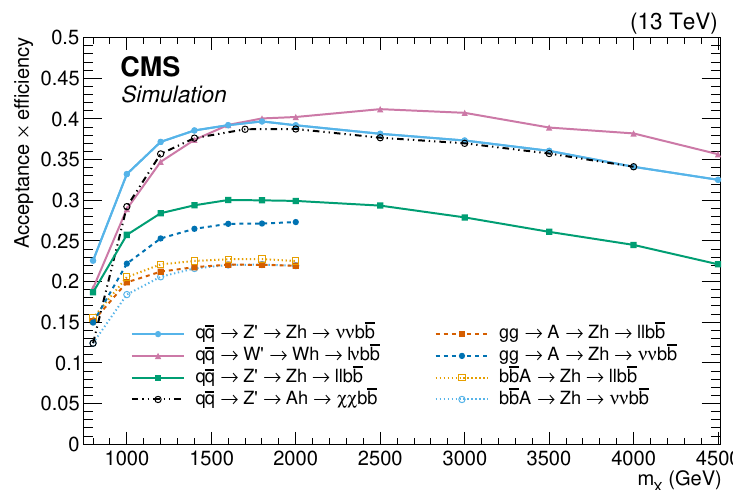
Figure 2 . The product of acceptance and e(cid:14)ciency for the various signal processes and for di(cid:11)erent assumed masses of the resonances m V 0 or m A . The dash-dotted and solid lines indicate spin-0 and spin-1 resonances, respectively, in di(cid:11)erent production or decay modes. The dashed line represents the spin-1 resonance in the Z 0 -2HDM model with m A = 300 GeV. The e(cid:14)ciencies are derived by considering only the relevant decay modes of the vector bosons (e, (cid:22) , or (cid:28) ), and represent the sum of the e(cid:14)ciencies in the 1 and 2 b tag